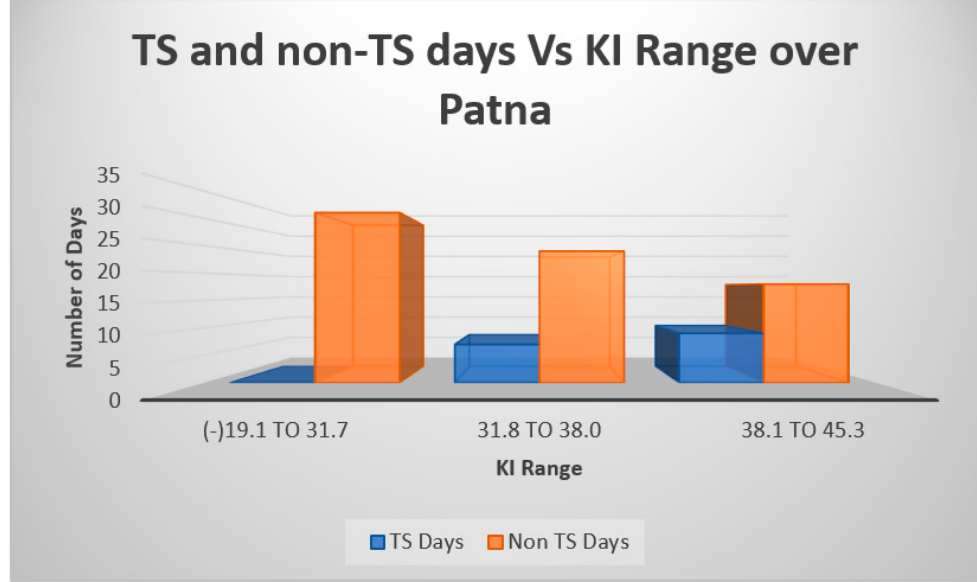
Figure 7. Distribution of thunderstorm and non ‐ thunderstorm days in the given KI range over